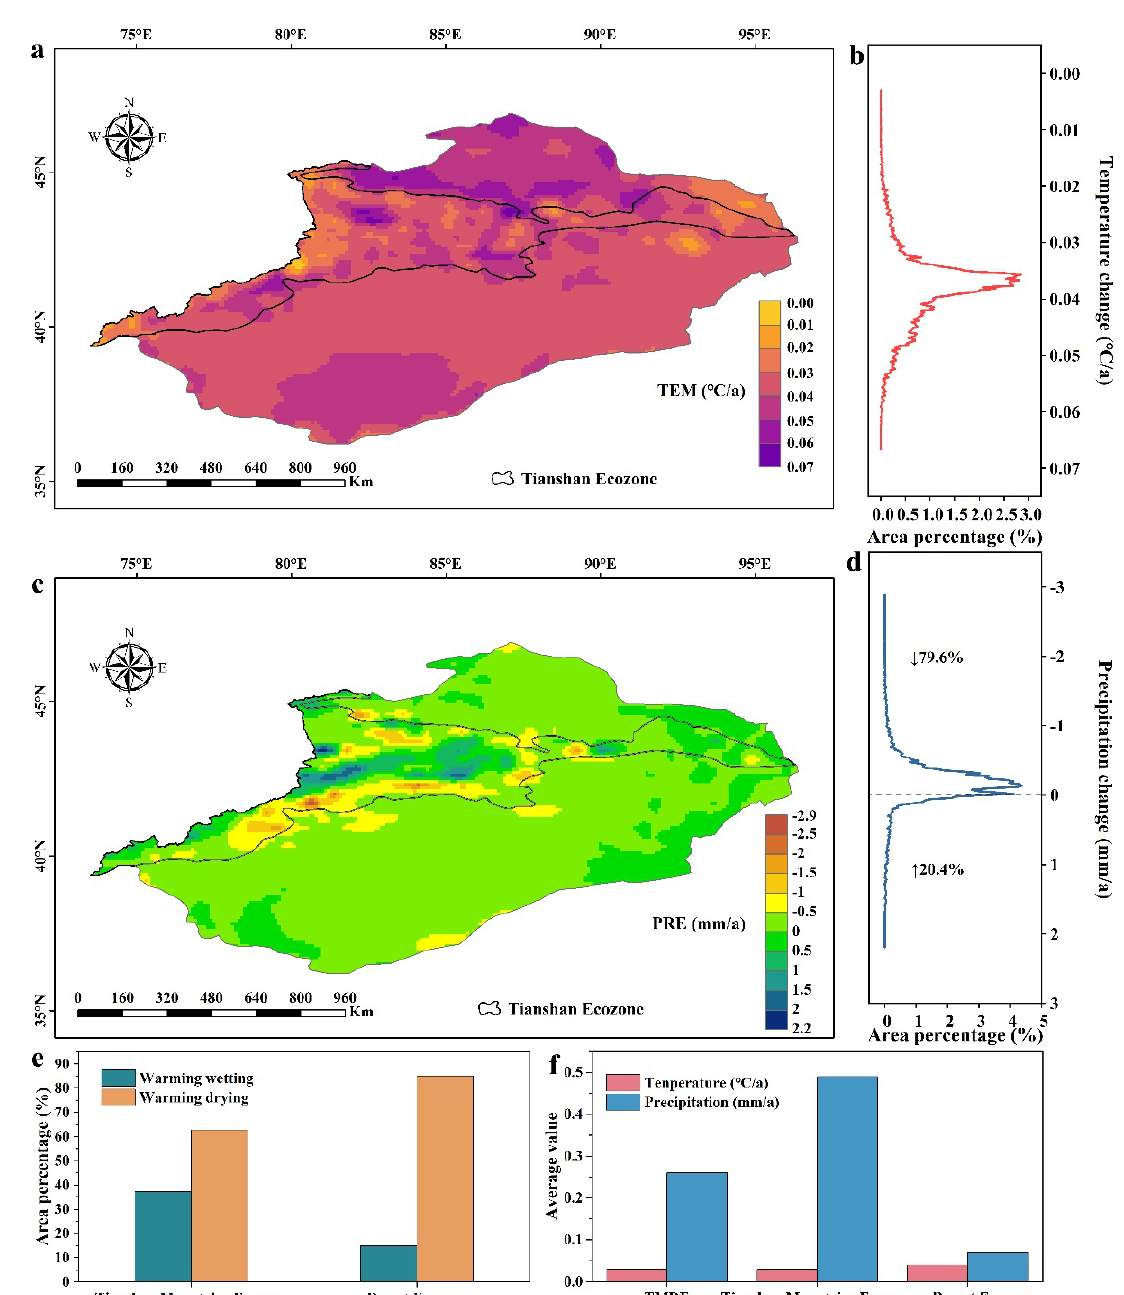
Figure 2. Spatial distribution of temperature and precipitation trends. ( a , c ): spatial distribution of temperature and precipitation trends. ( b , d ): frequency distributions of rates of changes in temperature and precipitation. ( e ): proportion of warming and wetting and warming and drying grid cells in the Tianshan Mountains Ecozone and Desert Ecozone. ( f ): mean annual change in temperature and precipitation for the warming-wetting subset of each